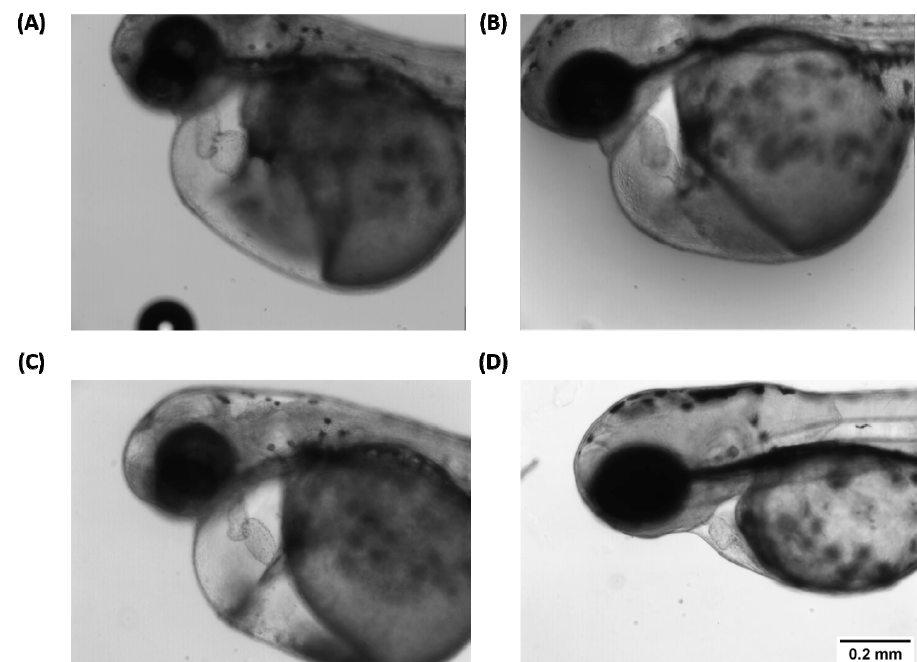
Figure A3. Typical cardiac morphology after exposed to carbofuran in zebrafish embryos aged at 72 hpf (hour post-fertilization). Zebrafish have larger cardiac chamber size at different severity which is the characteristic of cardiac edema ( A – C ) compared to the control ( D ).